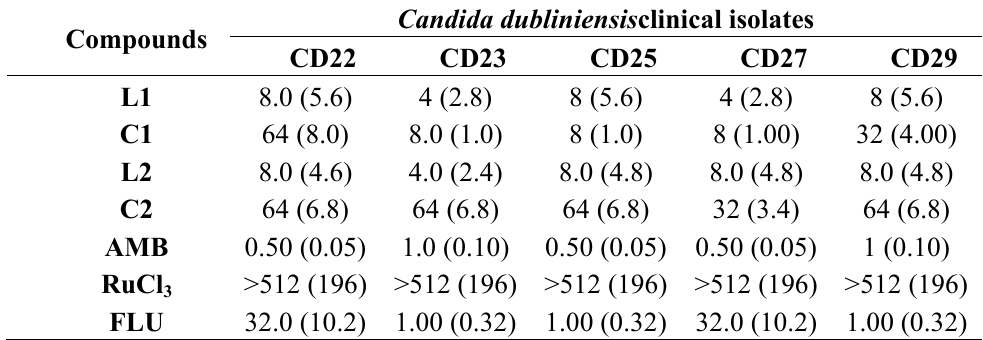
Table 3. In vitro susceptibility—MIC: μ g mL − 1 (10 − 5 mol L − 1 ) of Candida dubliniensis clinical isolate CD28 for pentakis-dithiocarbamate diruthenium complexes and free ligands by microdilution methods.